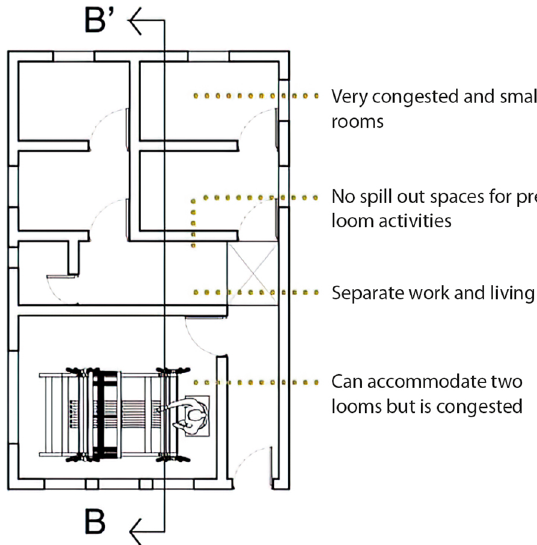
Fig. 16 Floor plan of single-family dwelling and its